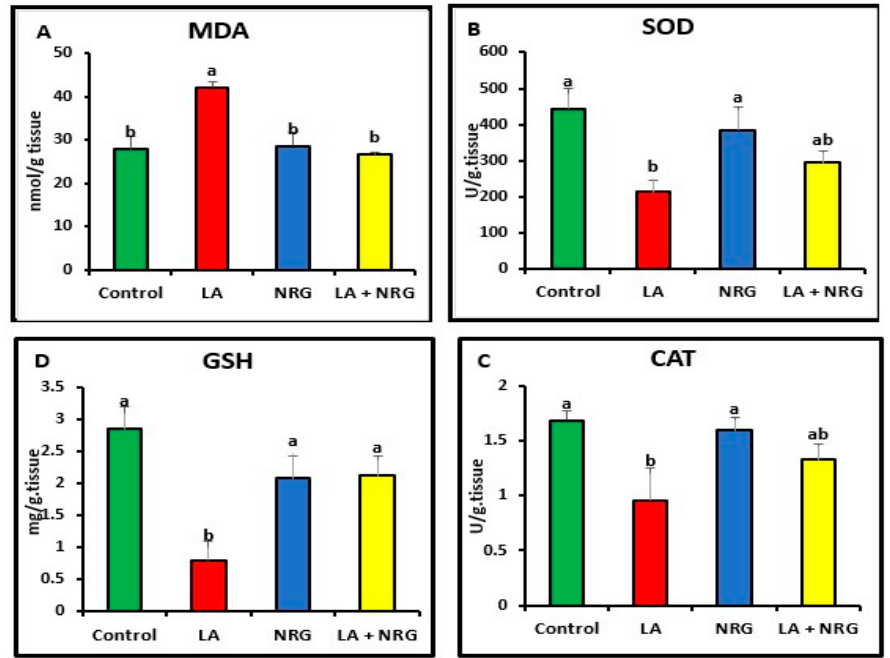
Figure 4. Hepatic oxidative/antioxidative parameters: ( A ) MDA (nmol/g tissue), ( B ) SOD (U/g tissue), ( C ) catalase (U/g tissue), and ( D ) GSH (mg/g tissue) at the 4th week of treatment of LA-intox- icated rats with NRG (mean ± SE)). The means in each chart with di ff erent superscripts are signi fi - cantly di ff erent ( p < 0.05). MDA: malondialdehyde; SOD: superoxide dismutase; CAT: catalase; GSH: reduced glutathione . a for the high value; while b for the lower value.